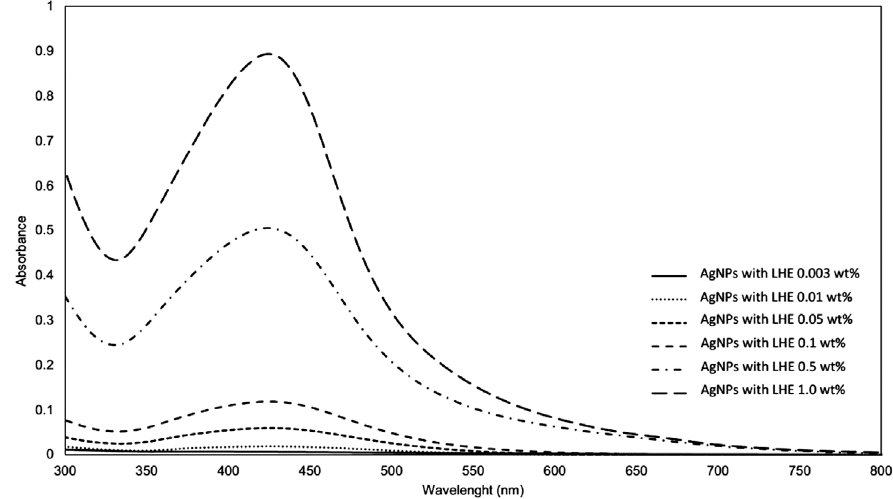
Figure 3: UV-Vis spectra of AgNPs reduced by LHE concentration vary from 0.003 wt% to 1.0